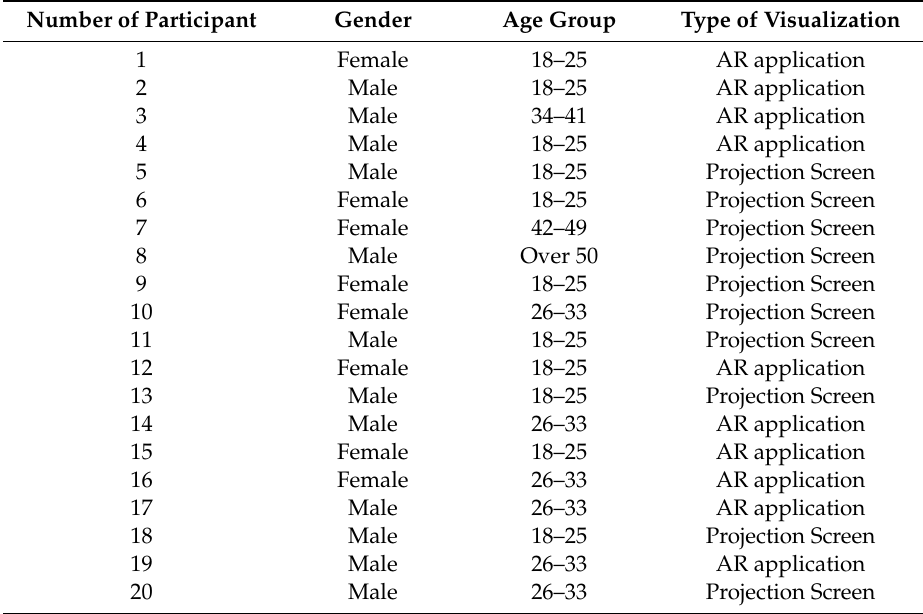
Table 1. Age and gender of participants and used type of